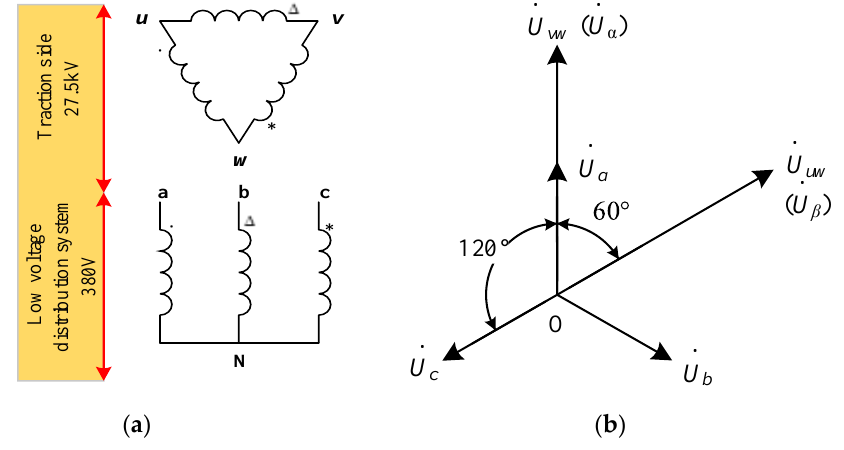
Figure 6. ( a ) D/y n transformer wiring diagram; ( b ) phasor diagram. The electrical coupling relationships of the primary and secondary sides are expressed as: (cid:34) . I α ( h )